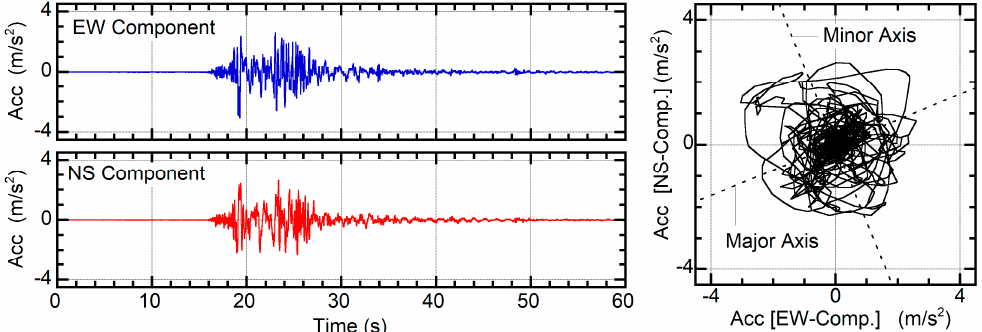
Figure A6 . Acceleration of EW- and NS-components and orbit of the record observed in the 14 April earthquake at the K-NET Uto Station.